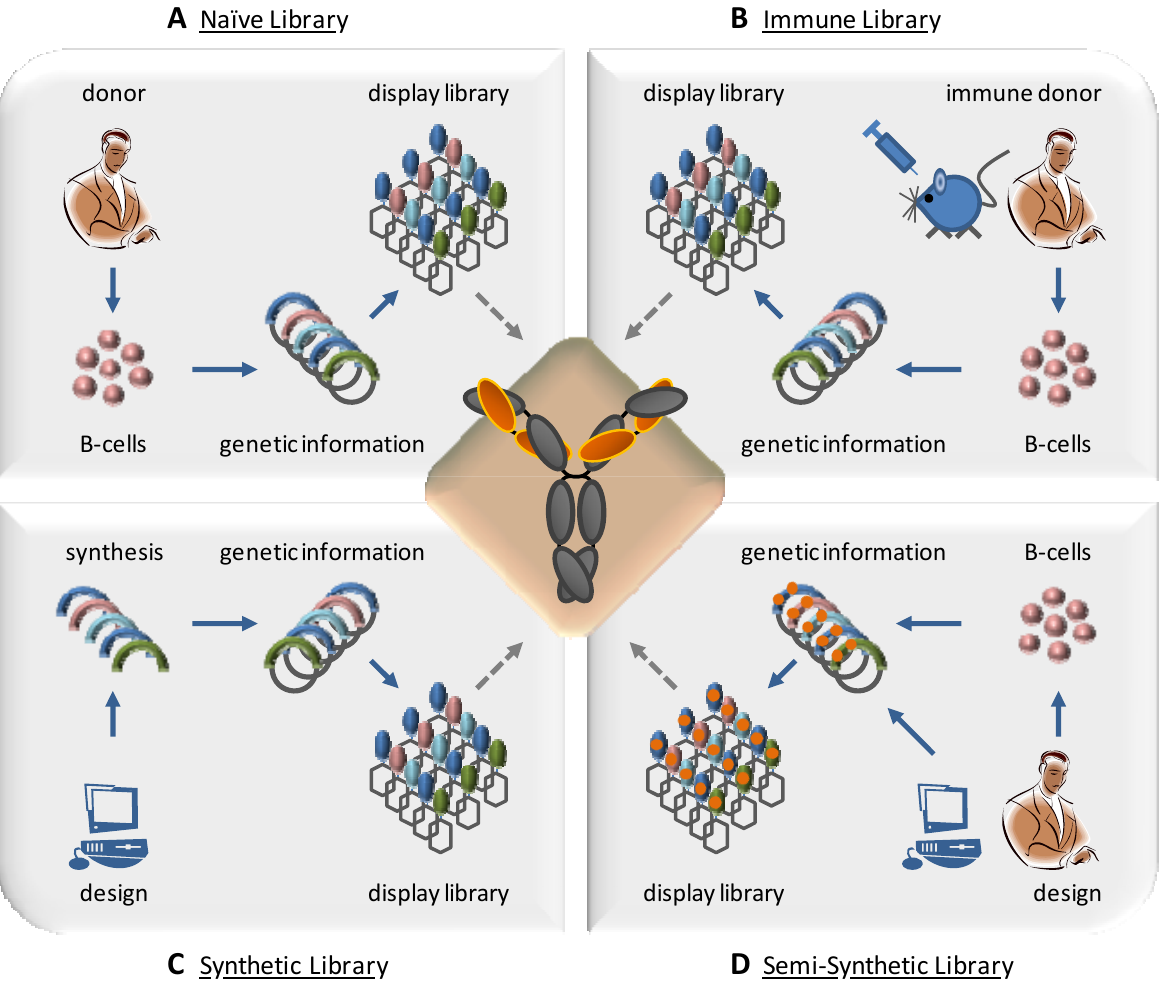
Figure 2. Four types of antibody libraries can be distinguished by source and design. A: Naïve libraries are amplified from a natural source, such as primary B-cells of non immunized donors. One library can be used for a wide variety of antigens. B: Immune libraries are generated from B-cell derived antibody repertoire of immunized or immune donors. Libraries are predisposed for a limited panel of antigens. C: Synthetic libraries are based on computational in silico design and gene synthesis. CDR design and composition is precisely defined and controlled. D: Semi-synthetic libraries comprise both CDRs from natural sources as well as in silico design of defined